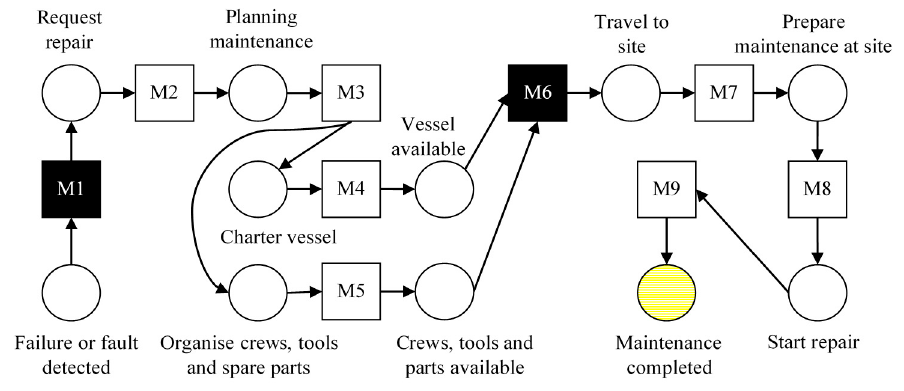
Figure 7. Recovery and Maintenance Petri Net (RMPN).